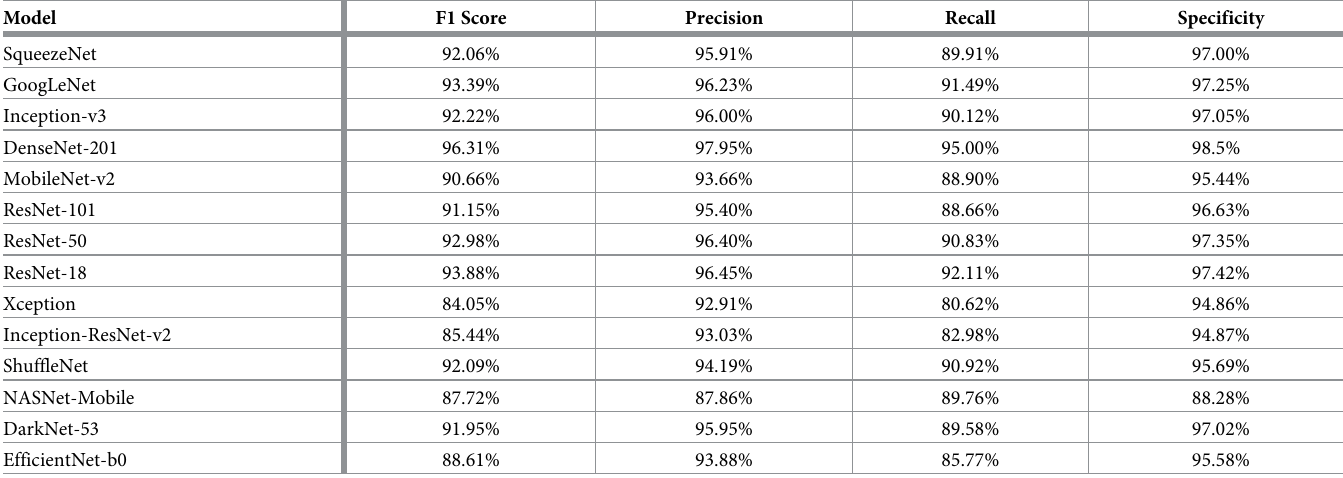
Table 8. The mean overall F1 score, precision, and recall parameters for the 14 deep learning models performing scoliosis vs spondylolisthesis classification.